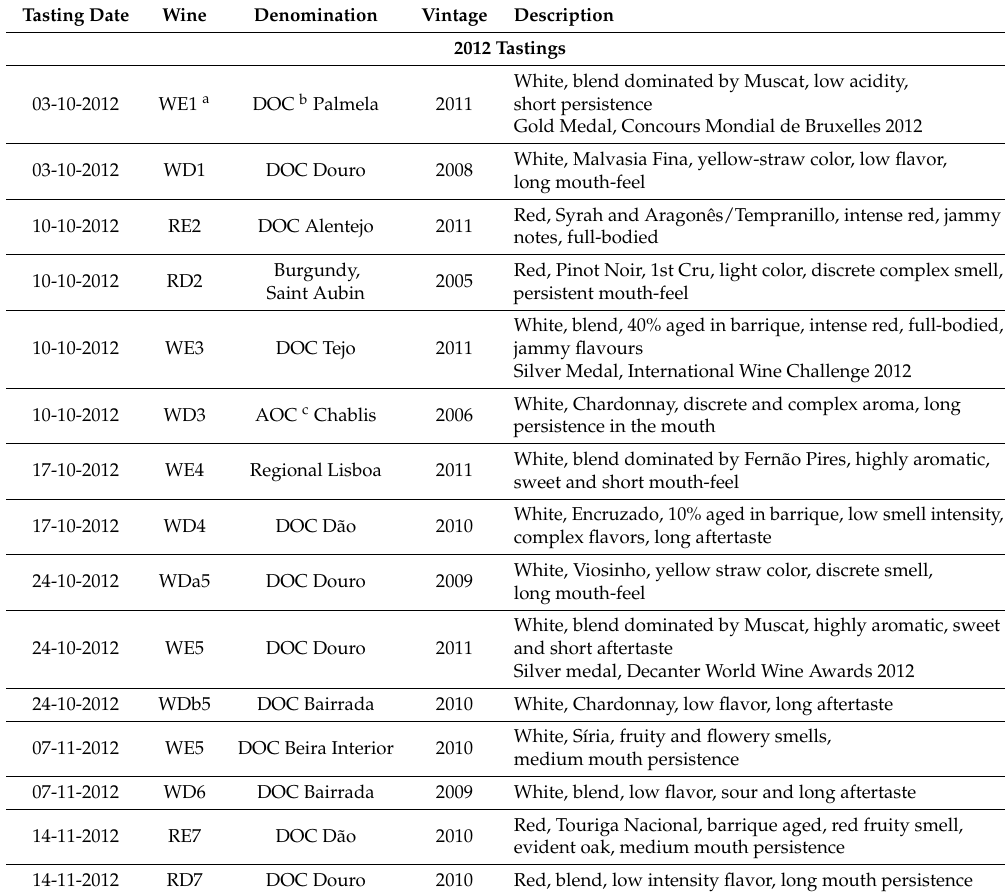
Table 4. Wines used in the 2012 and 2014 tasting